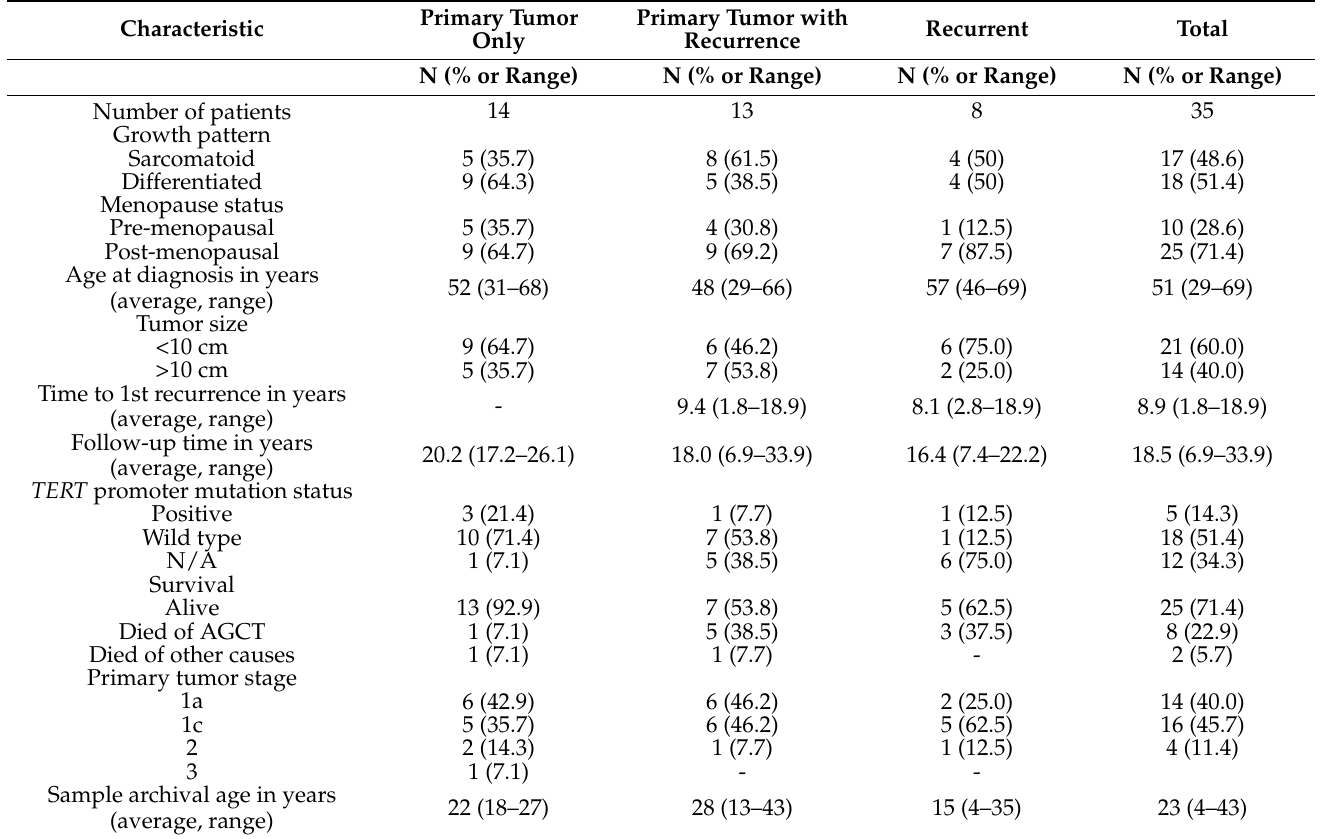
Figure 1. A cohort of archival AGCT samples was sequenced using Lexogen RNA 3 ′ QuantSeq. Originally 40 FOXL2 mutation validated AGCT samples were collected for this study. Table 1. Clinical characteristics of the AGCT patients in the Lexogen QuantSeq sample cohort.